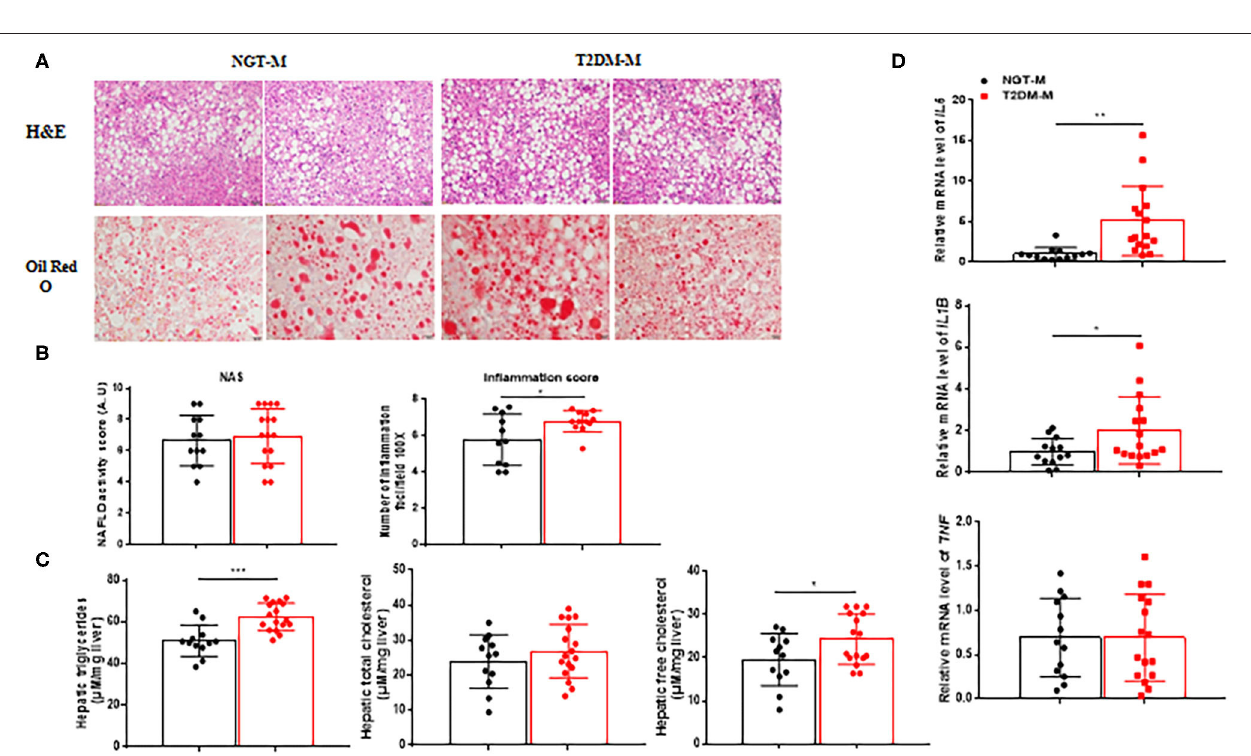
FIGURE 3 | Steatohepatitis was exacerbated in T2DM-M group compared with NGT-M group. (A) Representative liver HandE staining (magnification, × 200; scale bar: 50 µ m) and Oil Red O staining (magnification, × 400; scale bar: 20 µ m) ( n = 13–17). (B) Hepatic histological analysis of HandE staining (NAS and lobular inflammation score) ( n = 11–16). (C) Hepatic triglycerides and (free) cholesterol levels ( n = 12–17). (D) Quantitative real-time RT-PCR analysis of TNF IL1B IL6 mRNA expressions in the liver from MAFLD patients ( n = 13–16). The data are expressed as the mean ± SD, * P < 0.05, ** P < 0.01, and *** P <